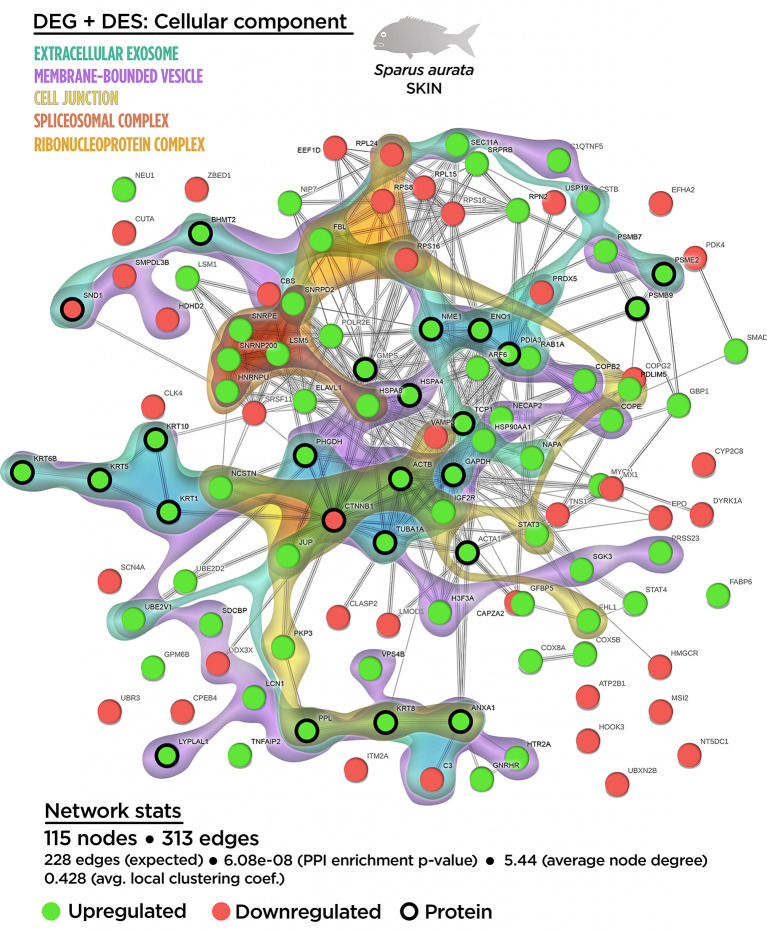
Integrative ameboid graphic for the cellular components obtained for the skin mutiomics-based interactome analysis in gilthead sea bream fed with SDPP supplemented diet. Each node represents one differential expressed gene (DEG) obtained from the skin transcriptomic analysis (circles) or one differential expressed spots (DES) obtained from the skin proteomic analysis (bold circles). The modulatory profile for DEGs or DES is represented with green (upregulated) and red (downregulated) into each node. The integrative cluster analysis groups the DEGs classified into each of the biological processes indicated in color (on top). The functional network statistics (Network stats) details is also indicated (bottom).